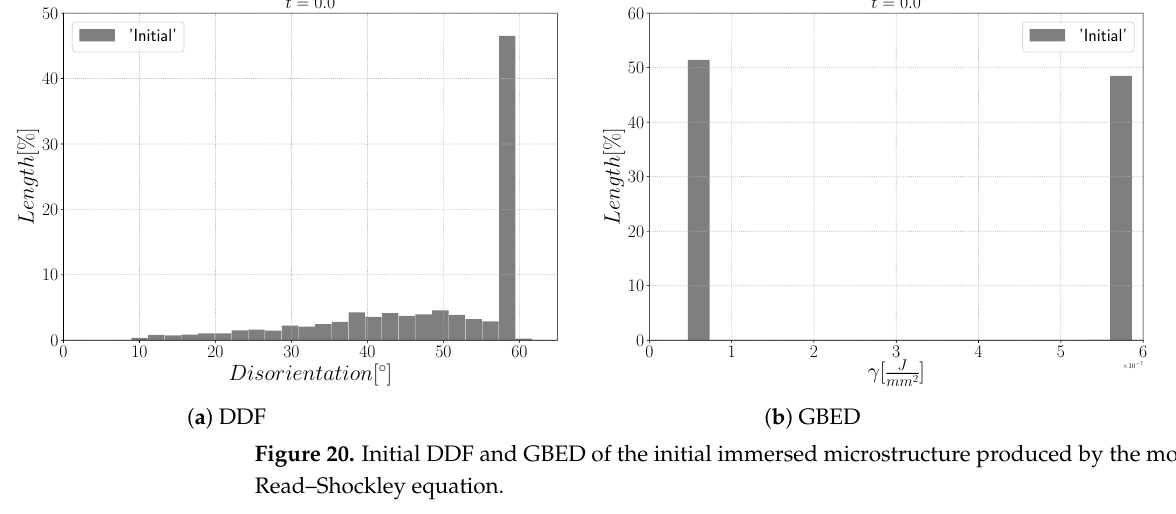
Figure 20. Initial DDF and GBED of the initial immersed microstructure produced by the modified Read–Shockley